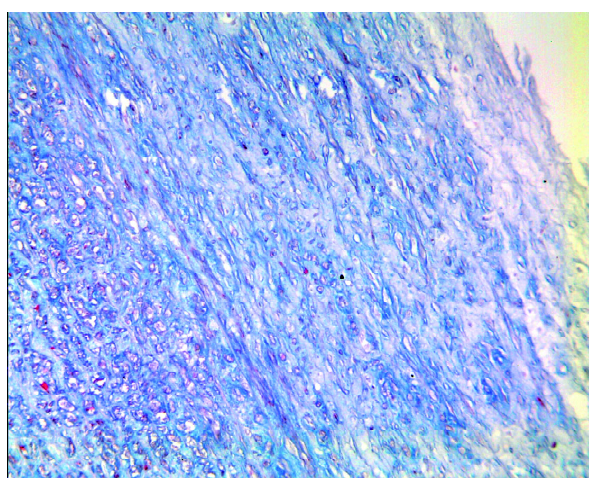
Fig. 6 – Histology of the ascending aorta of a 45-year-old male healthy subject showing more collagen deposition and extensive cystic-like lesions in the aortic intima and media.